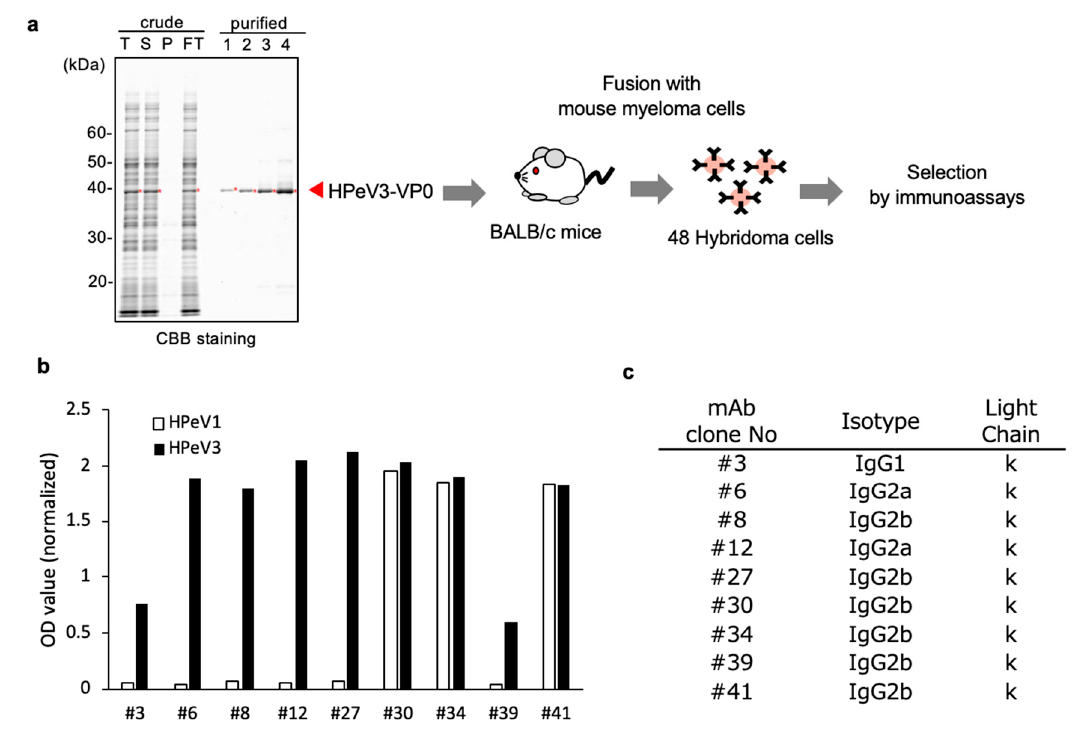
Figure 1. Production of anti-HPeV3 mAbs using wheat germ cell-free synthesized VP0 antigen. ( a ) Schematic representation of hybridoma cell production to generate anti-HPeV3 mAbs using the recombinant Histidine-tagged HPeV3-VP0 (His-VP0) protein produced by the wheat germ cell-free system, and then purified using nickel-chelated Sepharose beads. Each protein fraction was analyzed by SDS–PAGE and visualized by CBB staining. Red dots and arrow indicate the target protein. T—total fraction; S—supernatant; P—precipitate; FT—flow-through; and purified fractions 1–4. Purified His-HPeV3-VP0 antigen was injected into BALB/c mice. After 4 weeks, the spleen cells of immunized mice were fused with myeloma cells and 48 hybridoma clones were established. ( b ) Out of these 48 clones, nine exhibited relatively high reactivity to antigen proteins, as revealed by ELISA. We used HPeV1 and HPeV3 VP0 proteins as antigens. ( c ) Isotyping of selected mAbs-producing hybridoma clones.